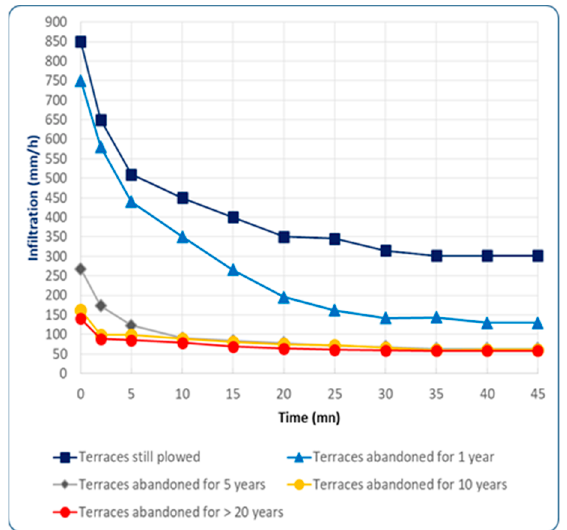
Figure 4. Water infiltration curves in the soil according to the age of abandonment of the terraces in the village of Tizerkine and Timzemzit, Ait Baha, Western Anti-Atlas, Morocco.